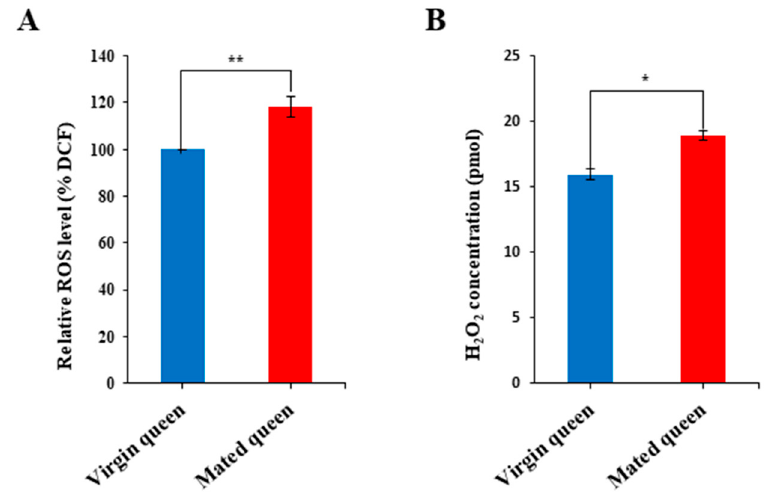
Figure 4. ROS ( A ) and H 2 O 2 ( B ) levels in the spermathecal fluid of virgin and mated queens. The levels of ROS and H 2 O 2 are shown relative to their levels in the spermathecal fluid of virgin queens (shown as 100%). The bars represent the mean ± SD values. * p < 0.05 and ** p < 0.01.